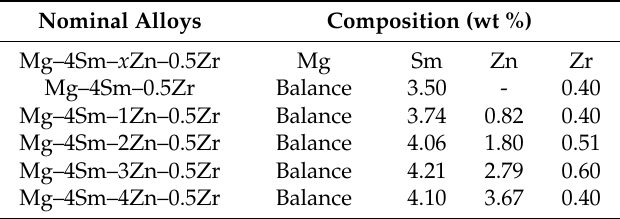
Table 1. Chemical compositions of the as-cast alloys with different zinc